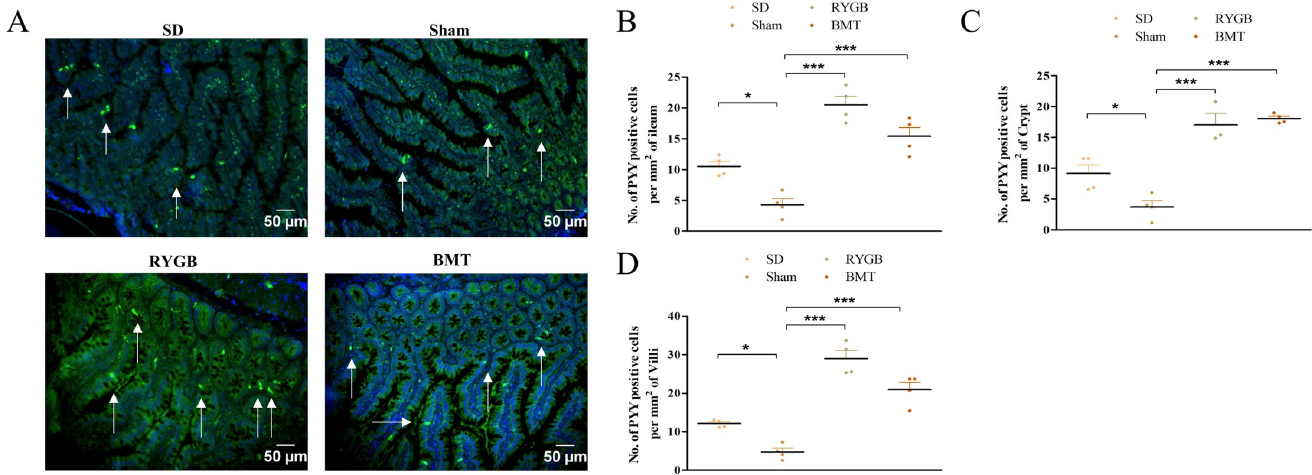
Fig 5. Effects of RYGB, BMT and sham surgery on PYY positive cell distribution in the ileum of ZDSD rat intestine. (A) Representative images showing PYY (green); arrows indicate PYY positive cells. Nuclei are demonstrated using DAPI staining (blue). (B) number of PYY positive cells per mm 2 of ileum, (C) number of PYY positive cells per mm 2 of crypt and (D) number of PYY positive cells per mm 2 of villi analyzed in ileum sections. Normal SD rats are included for comparison. Values are mean ± SEM (n = 4) with statistical significance evaluated using one-way ANOVA. � p < 0.05, ��� p < 0.001 compared to sham. Analyses carried out on ~200 cells per